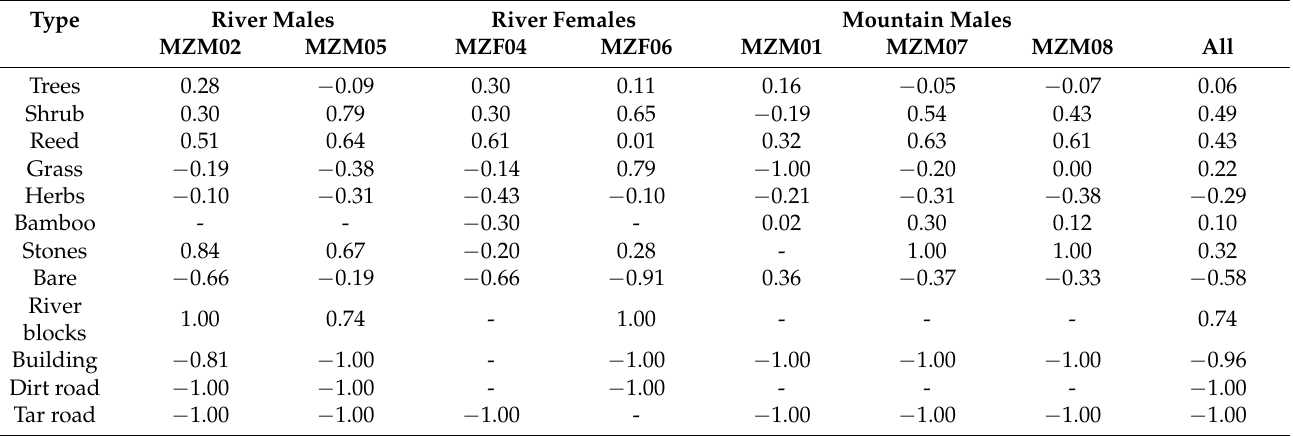
Table 5. Jacobs’ index for vegetation and other ground cover types at leopard cat daytime resting sites: vegetation and other ground cover types were selected (>0.2), avoided (< − 0.2) or used according to availability ( − 0.2–0.2), only vegetation and other ground cover types with a total sample size for resting sites and/or random points of >5 were